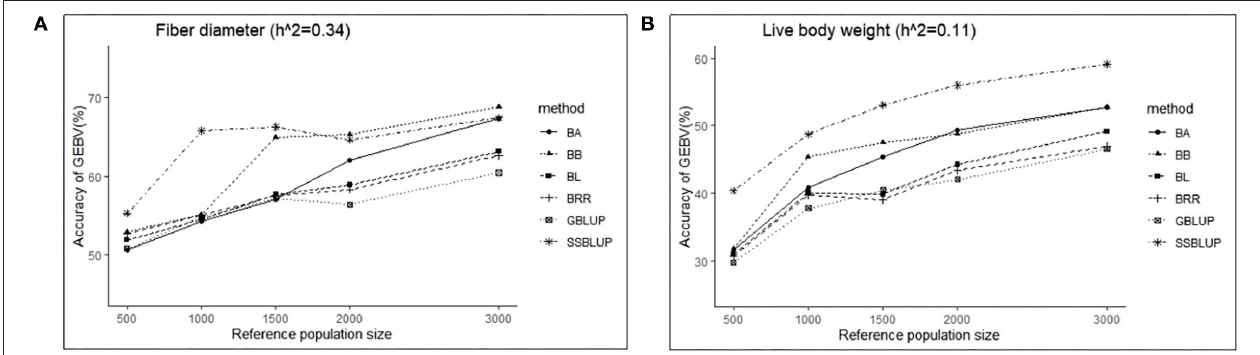
FIGURE 3 | The change trends of accuracy of GEBV with increasing reference population size with GBLUP and Bayes